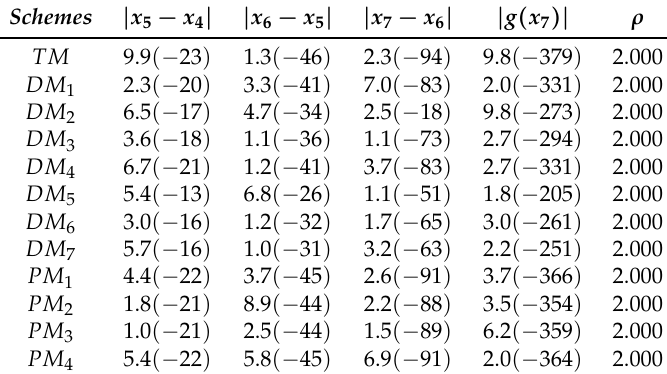
Table 6. Numerical results of Example 5.